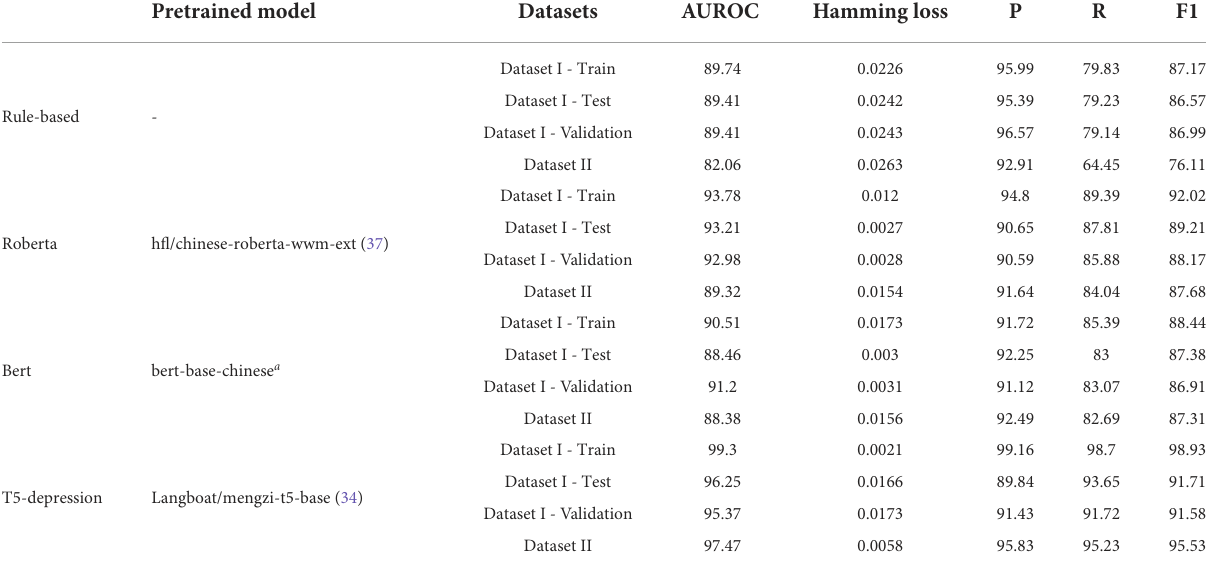
TABLE 2 Metrics for different models on Dataset I and II.